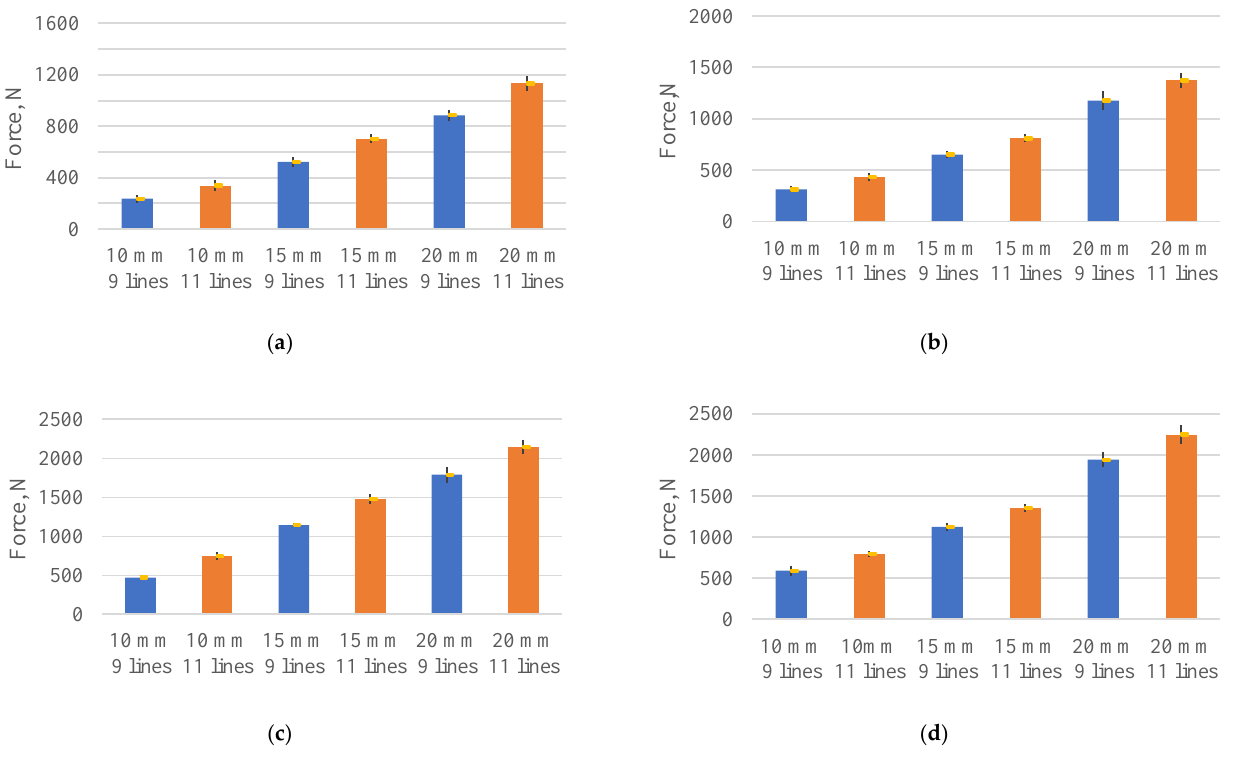
Figure 4. Diagrams of the shear force for the specimen with different line numbers and overlap lengths: ( a ) 1.2 – 0.4; ( b ) 1 – 0.4; ( c ) 1.2 – 0.3; ( d ) 1 – 0.3 .